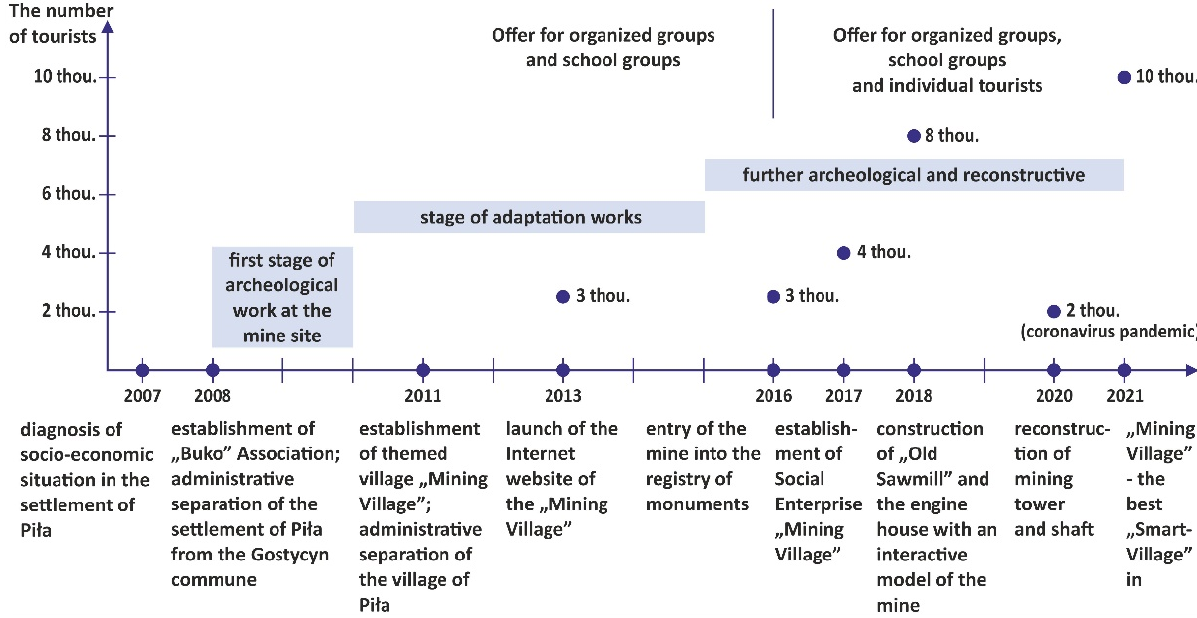
Figure 6. Educational elements in the mining village. ( A )—educational board, ( B )—”speaking stones”, ( C )—fragment of a model depicting the former mine.